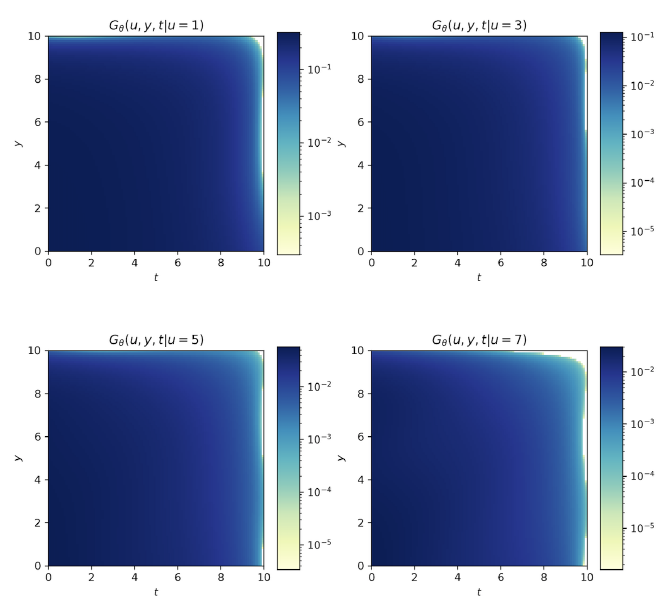
Figure 14. The values of G θ ( u , y , t ) for a given u (Pareto